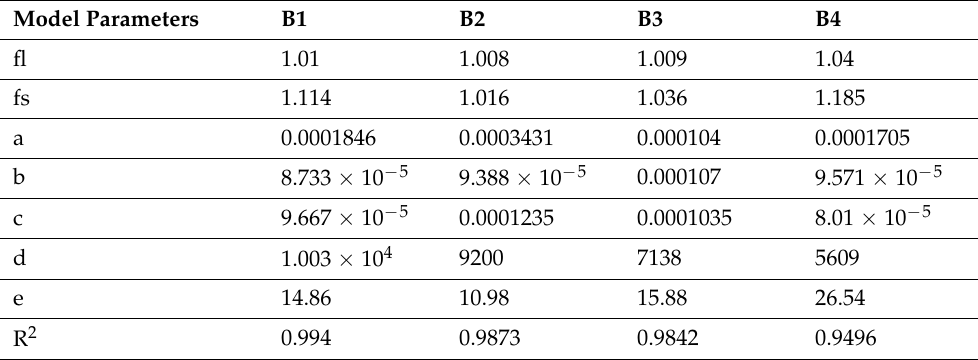
Table 4. Parameters of the model (8) for batteries with a different C-rate as a function of the number of equivalent